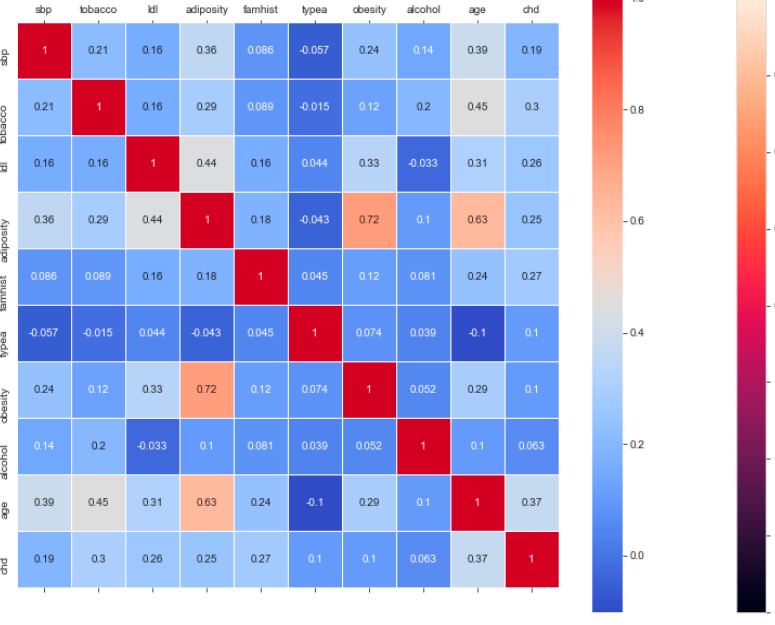
( b ) Figure 18. ( a ) Performance metric of the “SVM” classification with a 5-fold cross validation. ( b ) Performance metric of the “Logistic Regression” classification with a 5-fold cross validation. The logistic regression performed the best under the probability calibration method following the Brier score metric, as depicted in Figure 19.